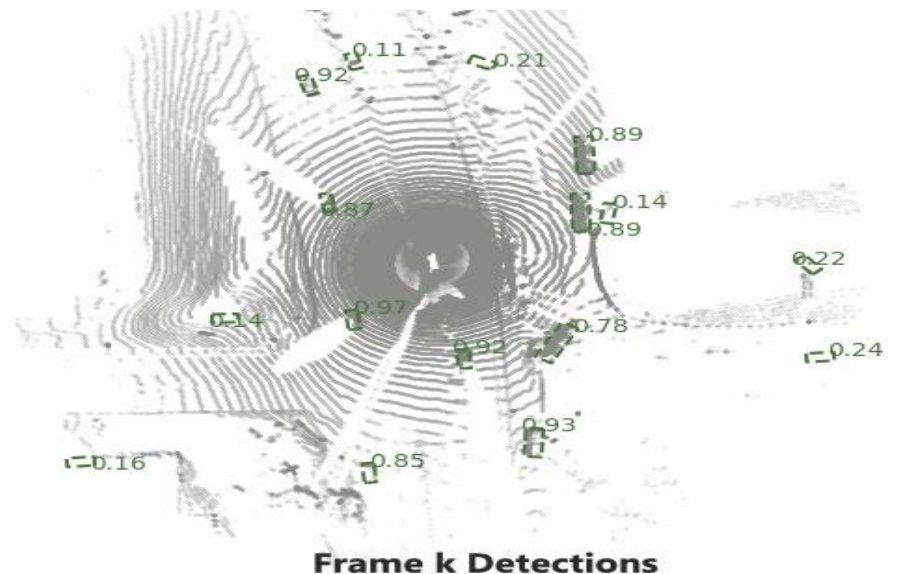
Figure 2. Vehicle bounding box detectors.